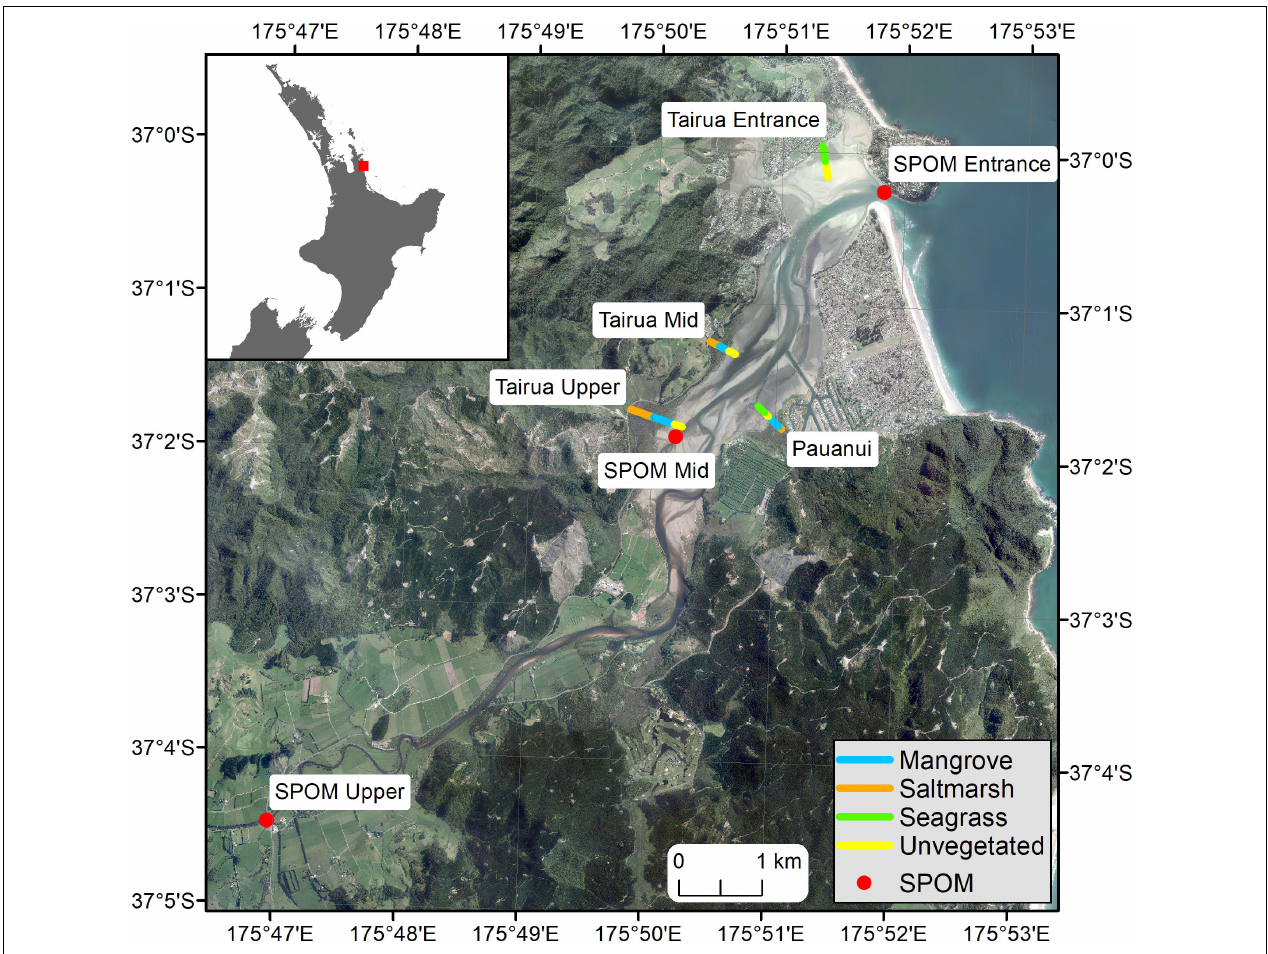
FIGURE 1 | Map of Tairua estuary, showing location and name of transects and SPOM collection points, color coded by habitat type. Orange, Saltmarsh; Blue, Mangrove; Green, Seagrass; Yellow, Unvegetated; Red, SPOM, Suspended Particulate Organic Matter collection